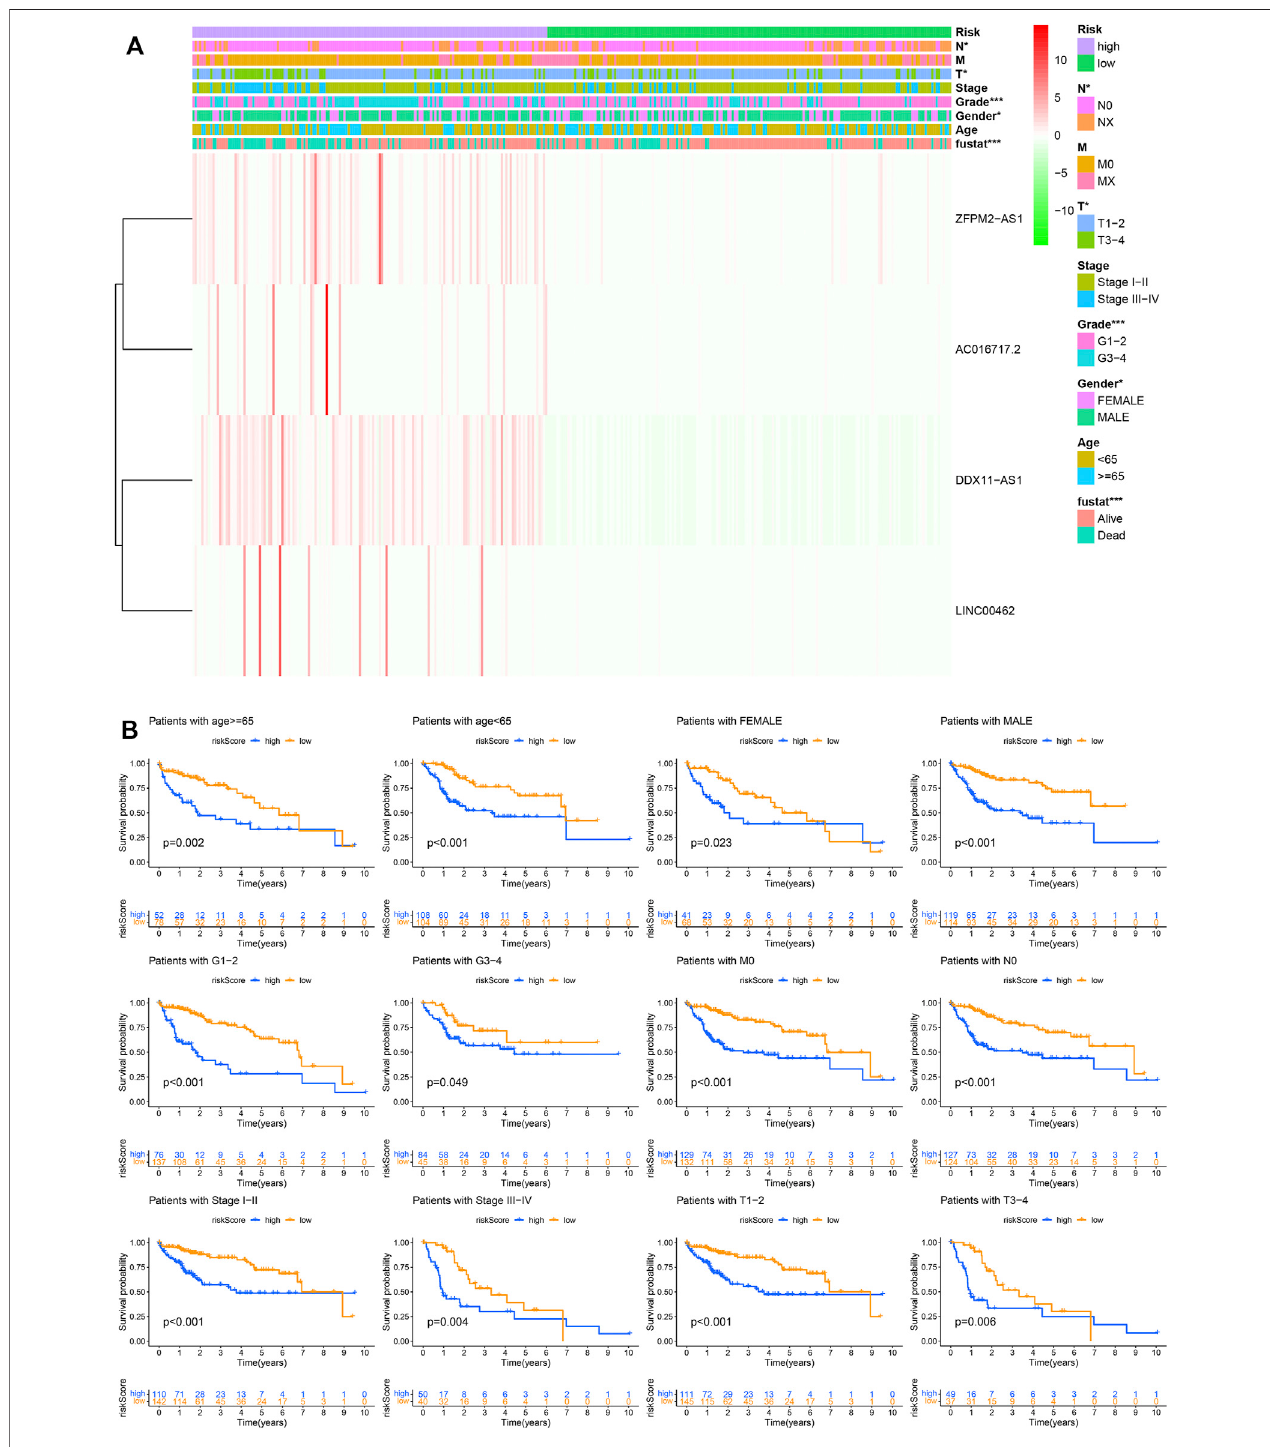
FIGURE 5 | The prognostic model and clinicopathological features. (A) The signi fi cance of clinicopathological features between high- and low-risk groups. (B) Prognostic differences in different groups.